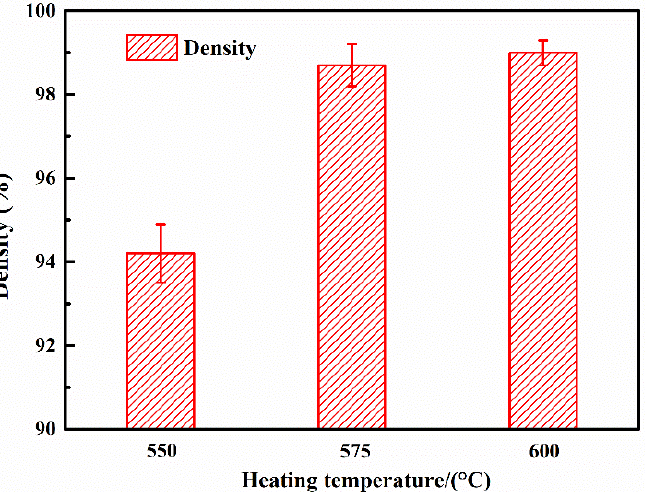
Figure 4. The relationship between relative density and fabrication temperature in the 25 vol.% AlN/Al composite.